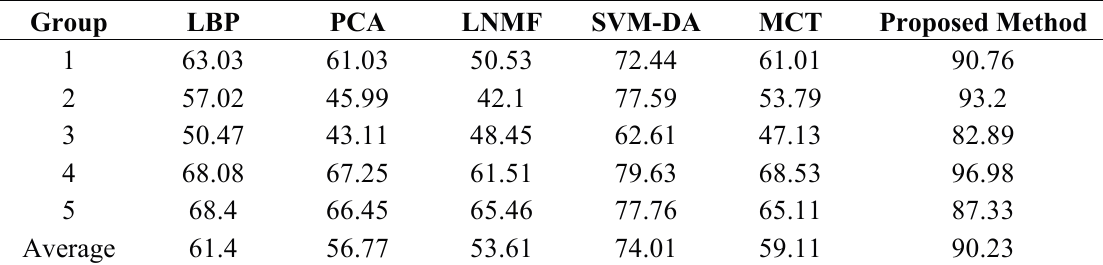
Table 6. The comparisons of face recognition accuracy (GAR) of our method to previous ones (unit: